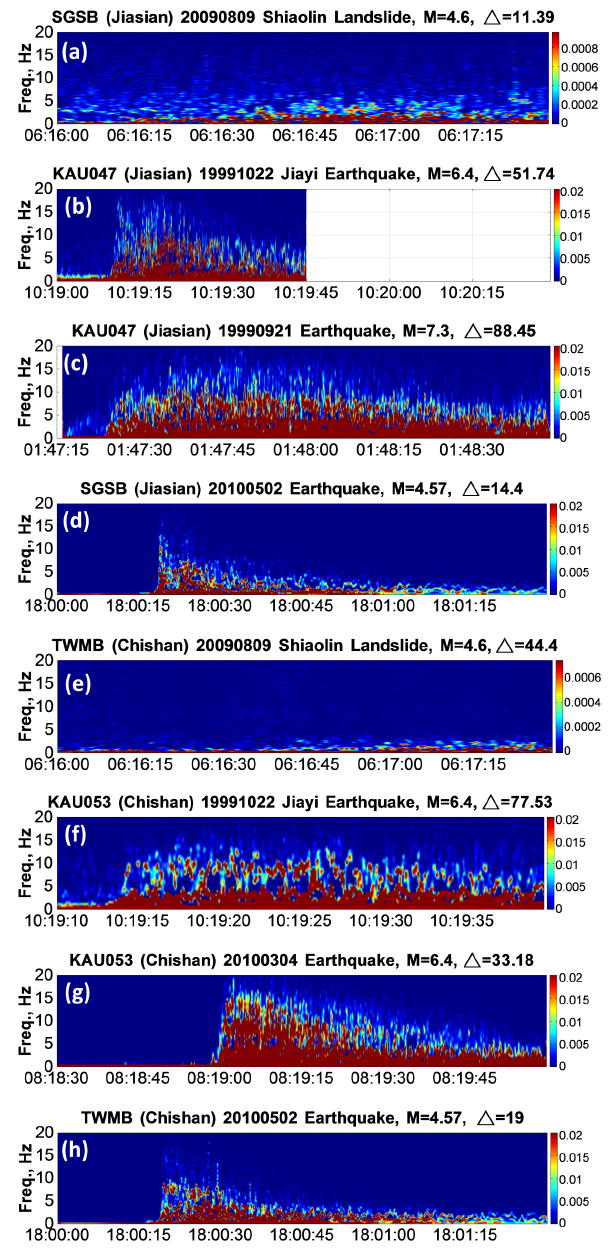
Figure 14The HHT time-frequency spectra of the earthquakes recorded at the Jiasian Fig. 14. The HHT time-frequency spectra of the earthquakes and Chishan free-field strong-motion and broadband stations.(M: Richter scale recorded at the Jiasian and Chishan free-field strong-motion and magnitude.) broadband stations. ( M : Richter scale